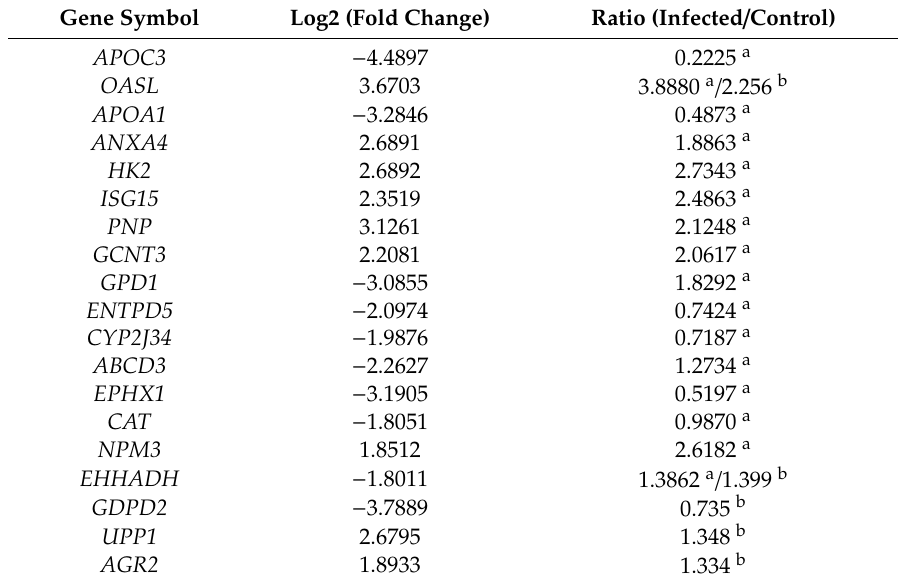
Table 1. Overlapped genes between our di ff erential expression analysis and previously identified proteomic expression changes in PEDV-infected and control